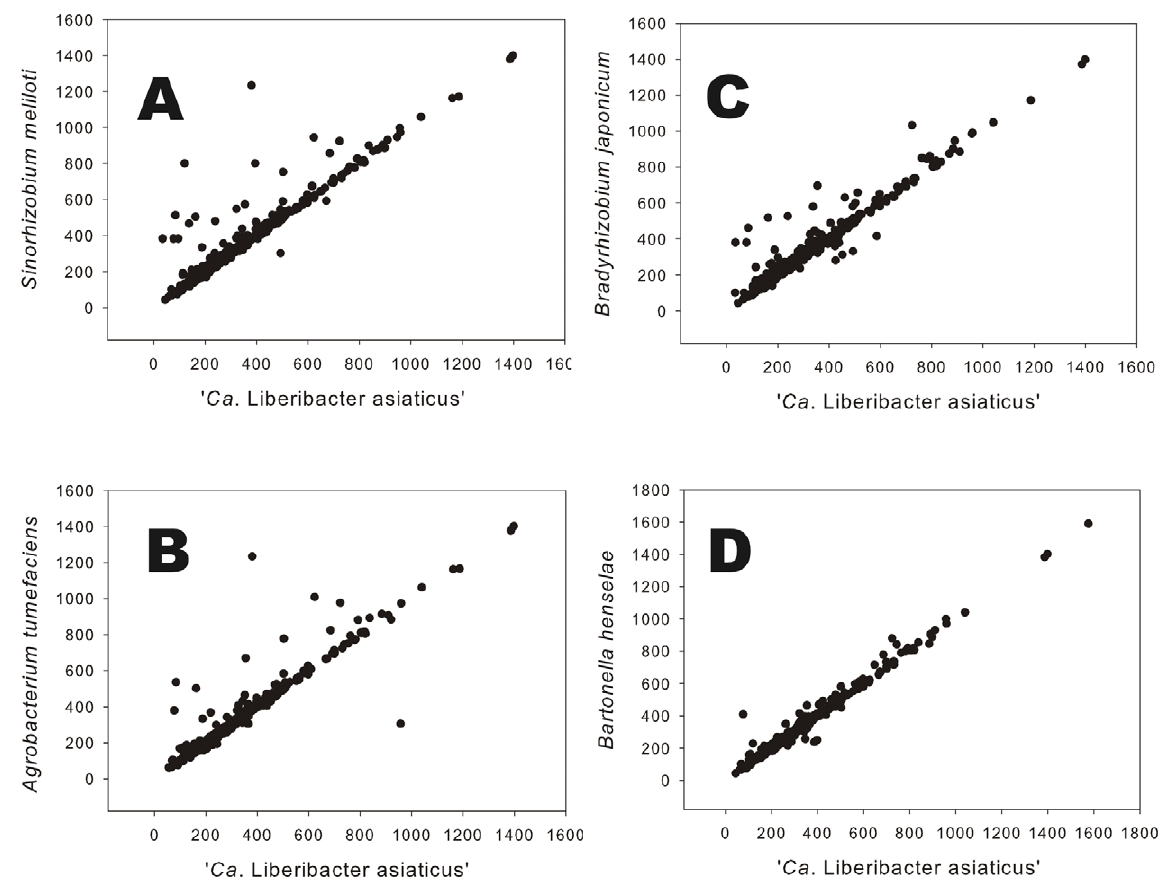
Figure 2. Number of amino acids in orthologous protein pairs. Orthologous proteins from ‘ Ca . Liberibacter asiaticus’ and Sinorhizobium meliloti (A), Agrobacterium tumefaciens (B), Bradyrhizobium japonicum (C) and Bartonella henselae (D).